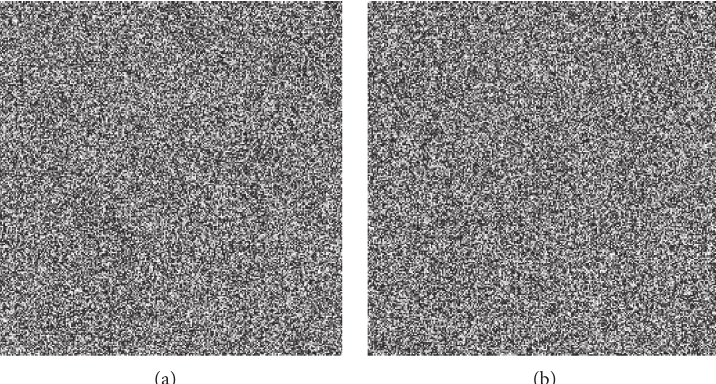
of Lorenz map changes from 10 to 10.0000000000001. (b) The decrypted 0